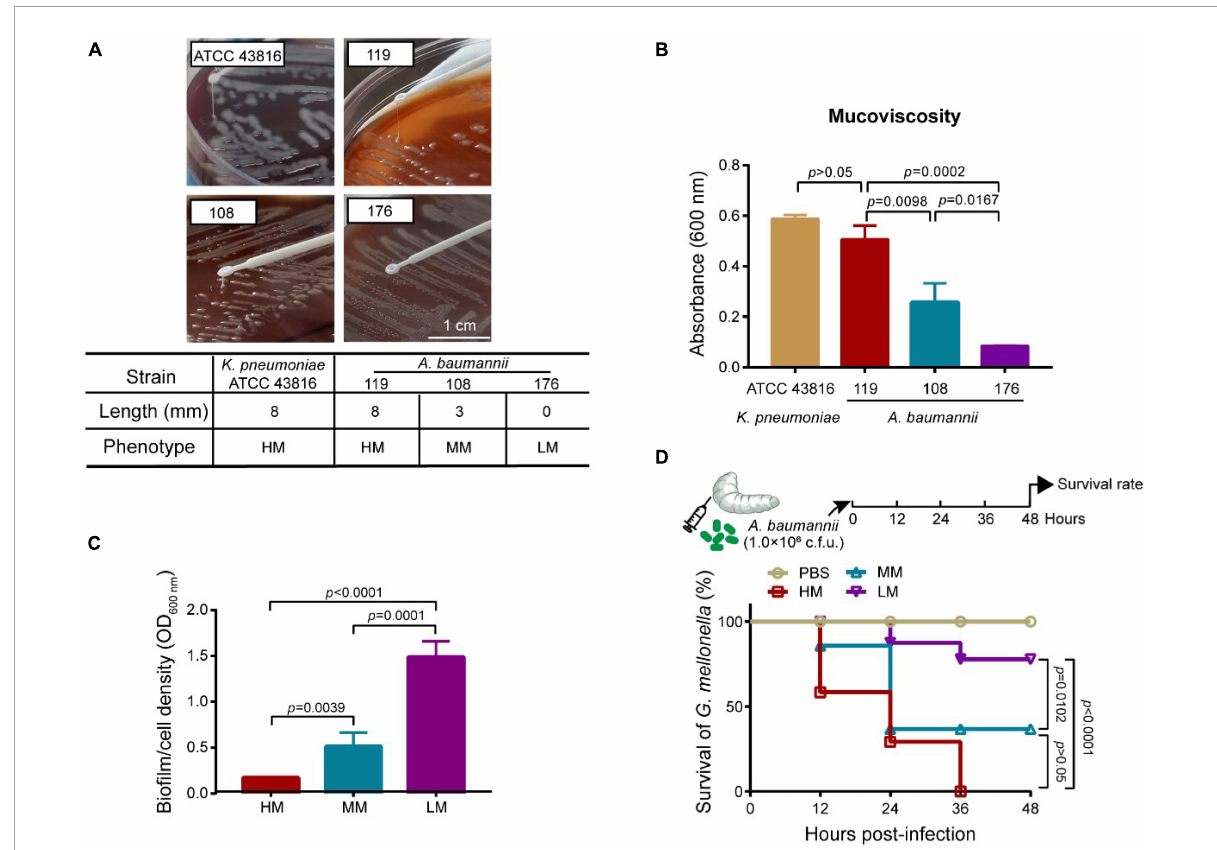
FIGURE1 Mucoid phenotype, biofilm production and toxicity of mucoid A. baumannii strains. (A) Stretching of the colonies on an agar plate. Inserted table showed the length of viscous string and phenotype of isolates (bottom). K. pneumoniae ATCC 43816 was used for hypermucoviscous control. Scale bar = 1 cm. (B) Measurement of mucoviscosity of different strains. (C) Quantitative analysis of biofilm abundance in A. baumannii isolates at 24 h. Experiments in panels (A–C) were performed as three biologically independent experiments, and the mean ± SD was shown. P values were determined using an unpaired, two-tailed Student’s t -test. (D) Survival rates of G. mellonella larvae. Infected larvae ( n = 7) with A. baumannii (1.0 × 10 6 CFU) at the right posterior gastropod. P values were determined using the two-sided, log[rank] (Mantel–Cox) test.